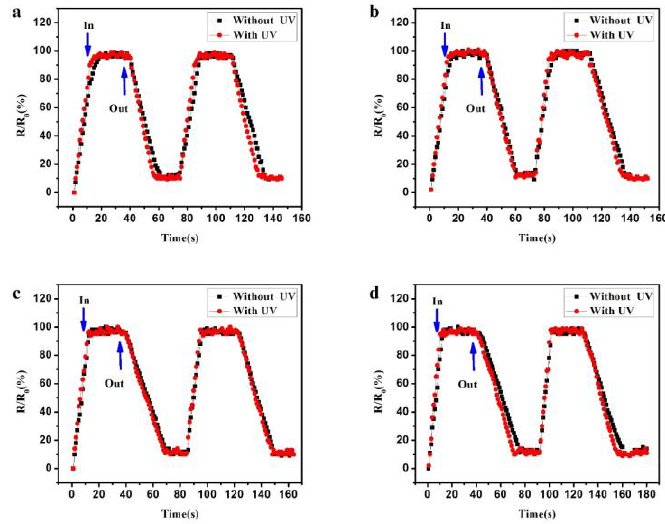
Figure 10. The response and recovery time at an applied voltage of 1 V, with and without UV irradiation: ( a ) 30%, ( b ) 50%, ( c ) 70%, and ( d ) 90%. Table 1. The response and recovery time at an applied voltage of 1 V, with and without UV irradiation. RH 30% 50% 70% 90% Response time 17 s Without UV Response With UV